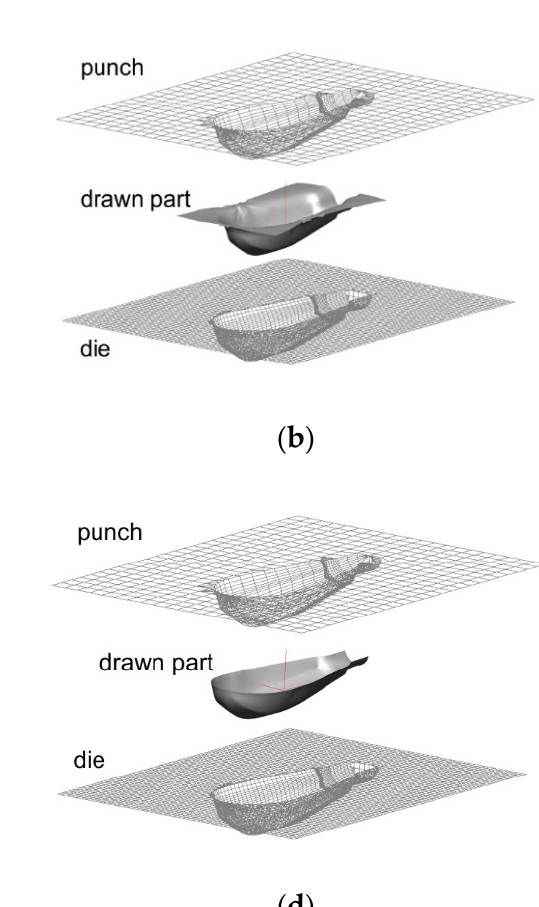
Figure 3. View of forming tool installed in UPV80 hydraulic press.